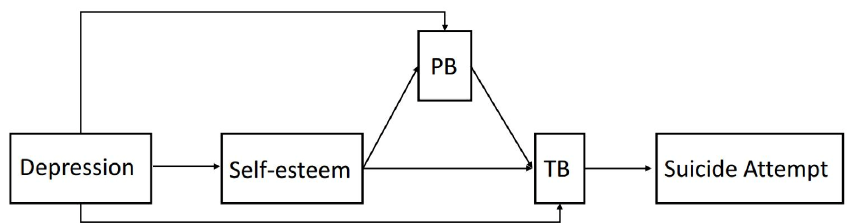
Figure 2. The alternative model that self-esteem predicts TB through the mediation of PB.